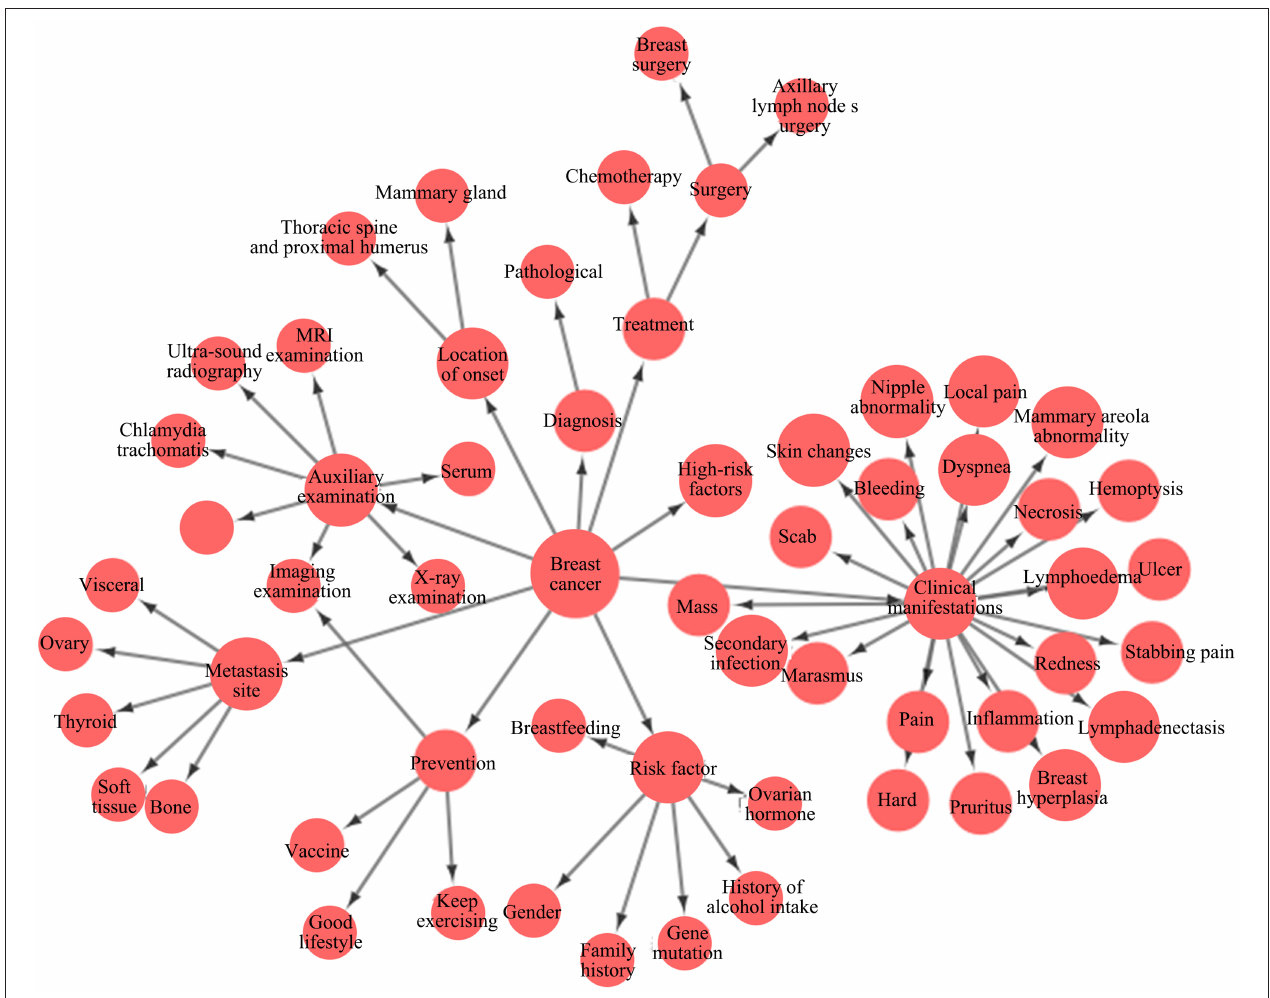
FIGURE 6 | Partial breast cancer knowledge